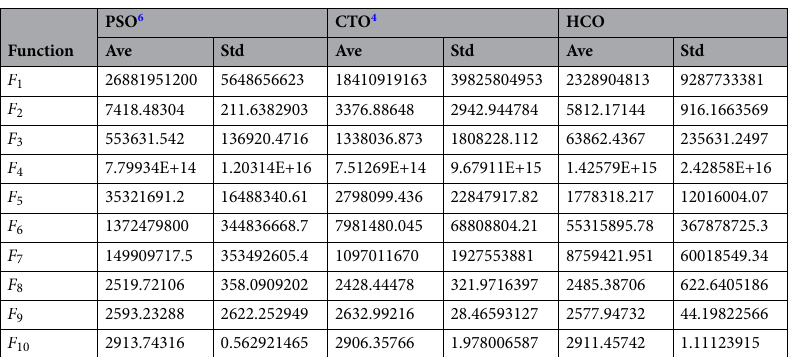
Table 4. Convergence performance of HCO for 30 dimensional CEC 2020 benchmark